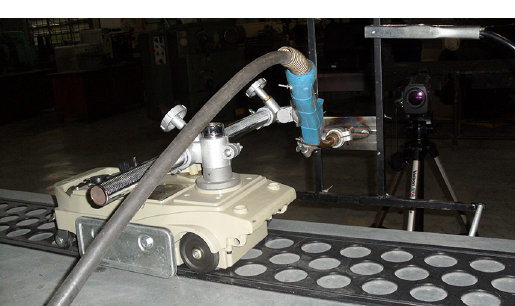
Figure 1. Automated GMAW process utilized in this